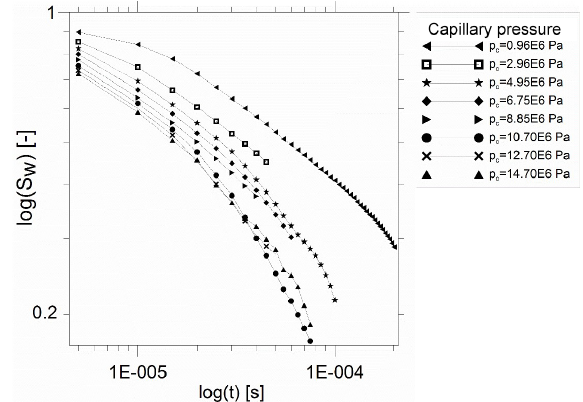
Figure 11. Plot of S w over t for each p c .